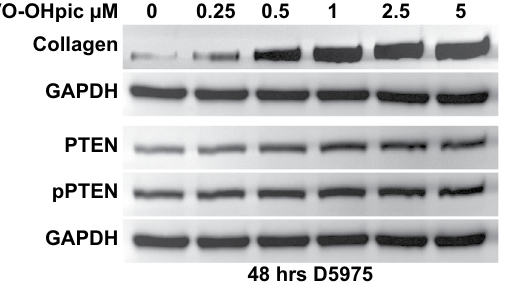
Figure 4. Inhibition of PTEN increases levels of collagen in human TM cells. Human TM cells were treated with VO-OHpic, a potent inhibitor of PTEN at varying concentrations. VO-OHpic at 5 μ M caused a nearly 4-fold (N = 3) increase in collagen levels at 48 h. A corresponding increase in the levels of PTEN and phosphorylated PTEN was noted. D5975- representative human donor.